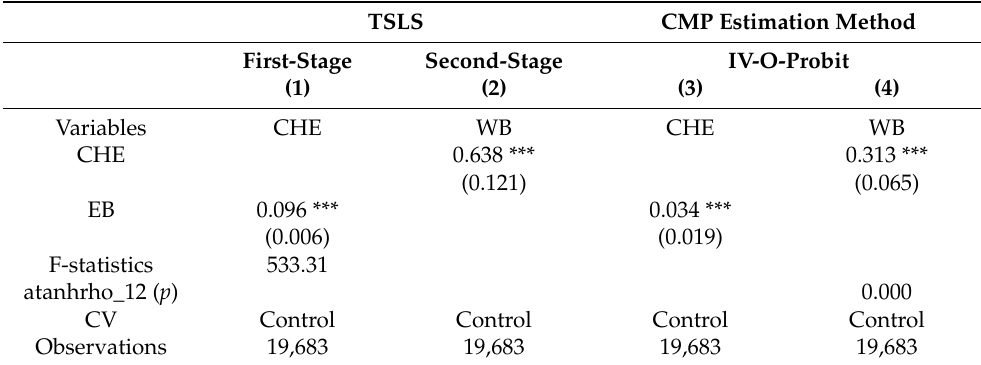
Table 5. The results of the IV-O-Probit model for endogenous